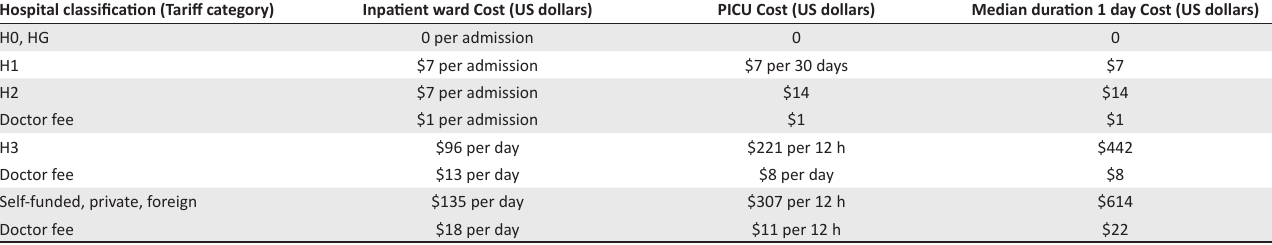
TABLE 1-A2: Hospital classifications, tariff classifications and relevant costs to patient. 7 Hospital classification (Tariff category)